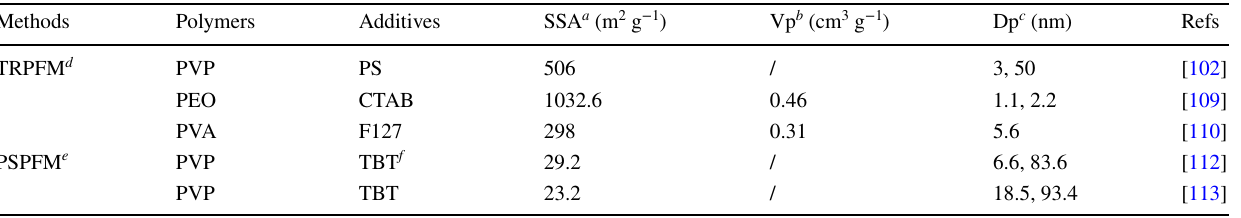
Table 1 Comparison of preparation methods of porous SNFs